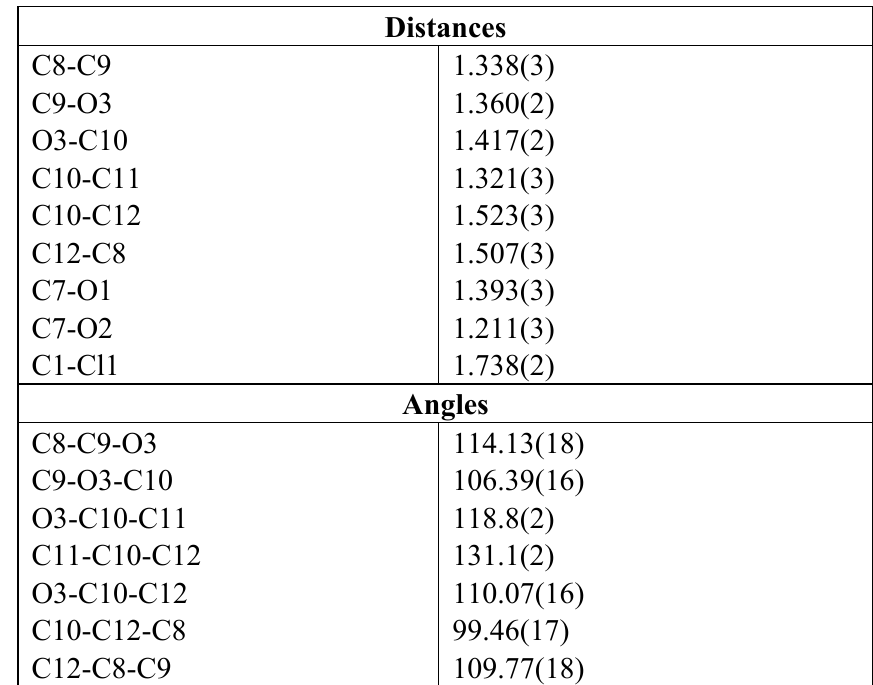
Table 2. Selected bond distances (Å) and angles (°) for compound 4a